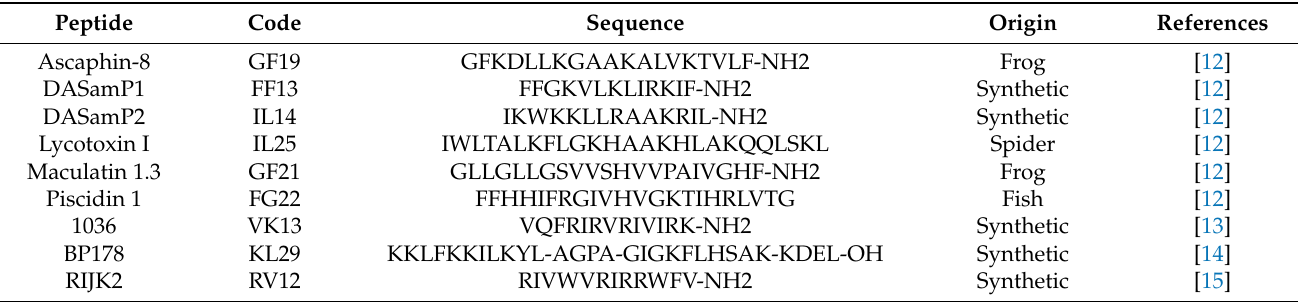
Table 1. The sequence and origin of the antimicrobial peptides used in this work.